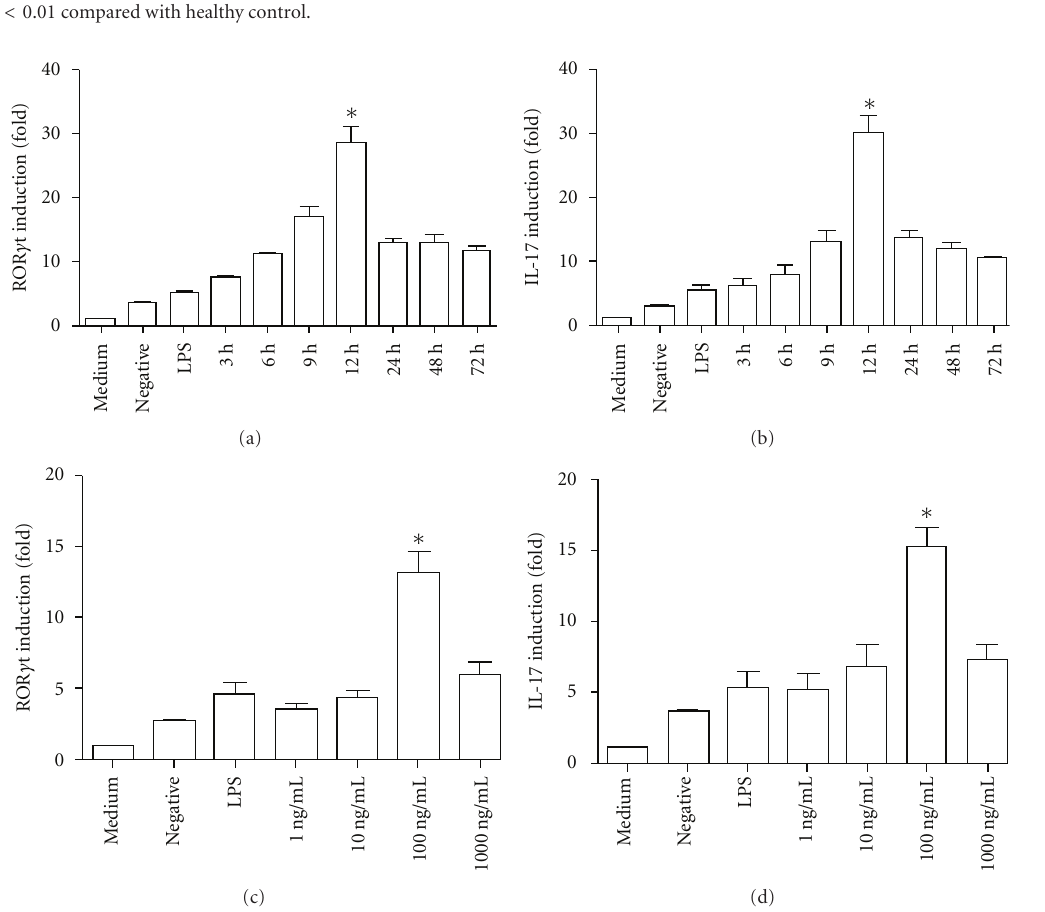
Figure 4: Th17 cell-related factors expression stimulated by HMGB 1 in vitro . Th17 cell-related factors expression by HMGB 1 stimulus in vitro were detected by RT-qPCR. The CD4 + T cells were isolated from mouse spleen, preactivated by anti-CD3 and anti-CD28, and then added to rHMGB 1. (a) ROR γ t mRNA expression levels after rHMGB1 stimulating in di ff erent time; (b) IL-17 mRNA expression leves after rHMGB 1 stimulus; (c) ROR γ t mRNA expression levels after rHMGB 1 stimulus; (d) IL-17 mRNA expression levels after CD4 + T cells stimulated by rHMGB 1 stimulus. RT-qPCR analysis for target genes versus β -actin mRNA expression, the ratios of target genes used the control as 1. Data from 3 independent experiments were presented as means ± s.d. ∗ P < 0 . 05 versus